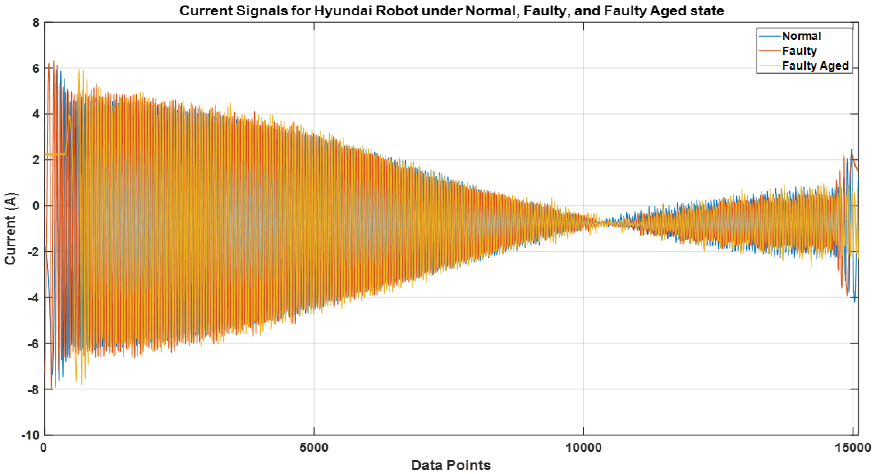
Figure 16. Electric current signal for one cycle of rotation for the Hyundai